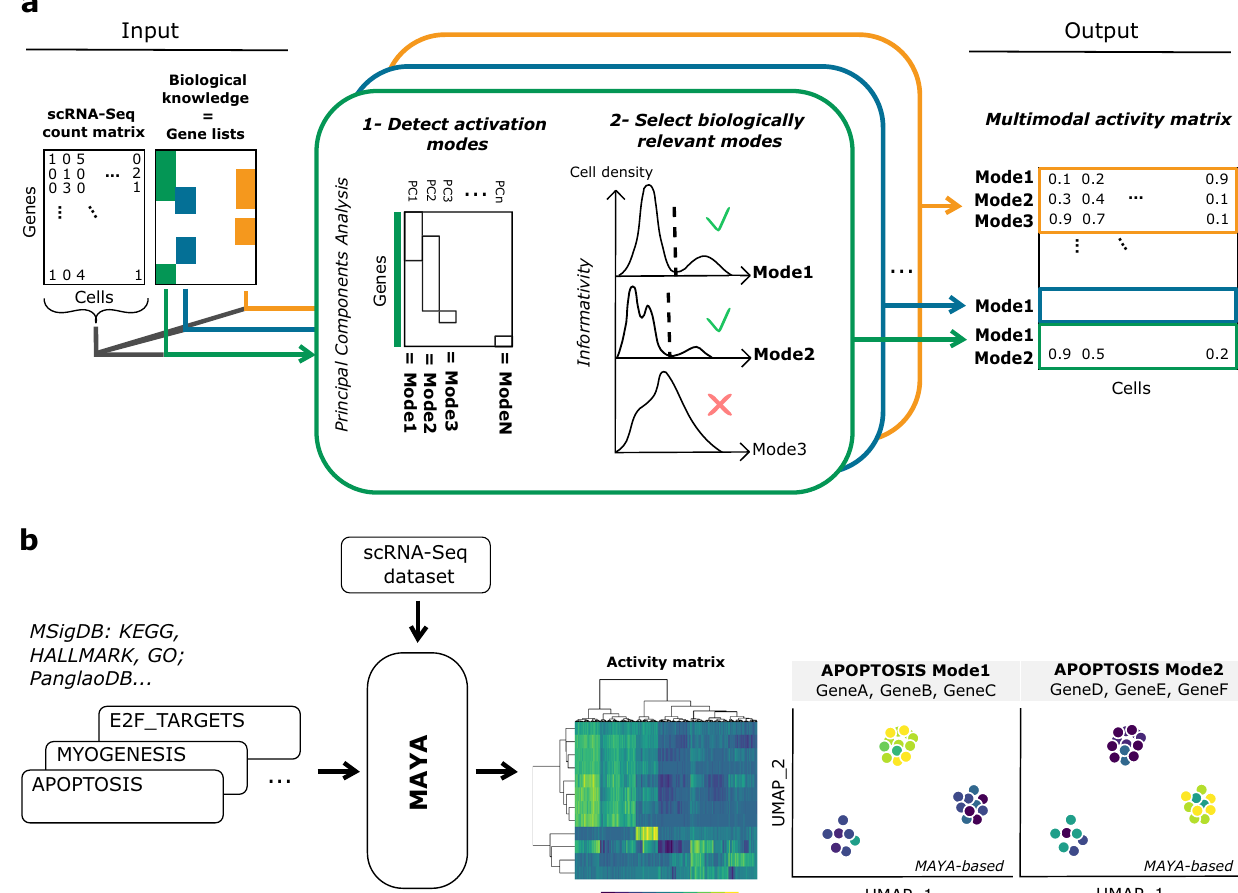
Fig. 1 | MAYAoverview. a MAYA takesasinput ascRNA-Seq dataset and reference gene lists, and produces as output an activity matrix, with for each cell its activity score for each mode of every reference gene list. b Example of MAYA outputs: a heatmap to visualize the modes of activation of reference pathways, or a Uniform